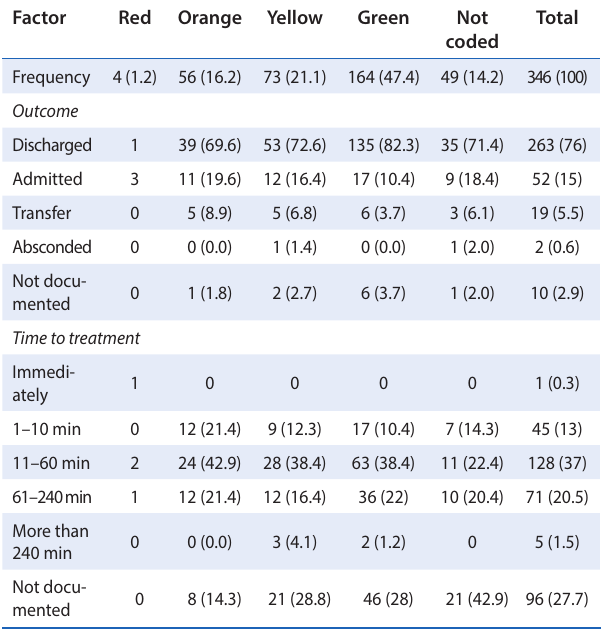
Note: Percentages (in parentheses) for outcome and time to treatment are of the total of each colour code. Table 4: Time of day seen cross-tabulated with final triage colour, recommended time to treatment and outcome